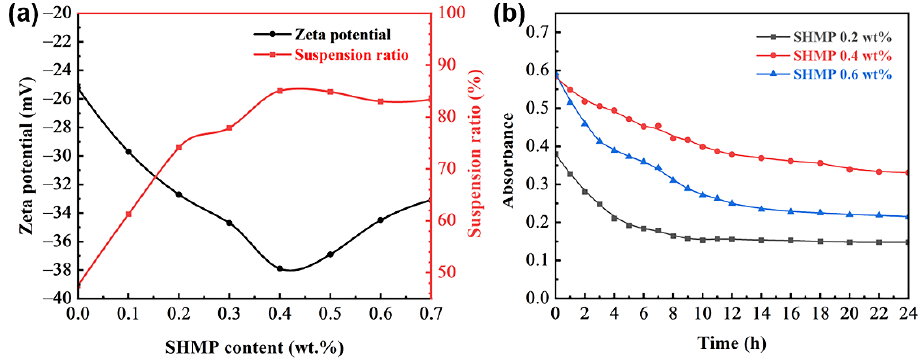
Figure 3. ( a ) Zeta potential and suspension ratio of quartz fiber slurries with different SHMP contents. ( b ) Absorbance of quartz fiber slurries with different SHMP contents at different standing times.